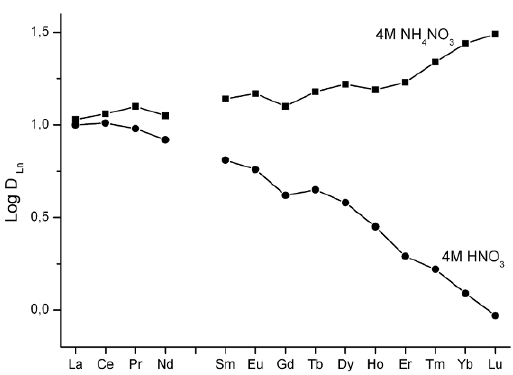
Figure 2. The extraction of lanthanides(III) from 4 M NH and 4 M HNO solutions with 0.01 M solution of compound 3 1 in 1,2-dichloroethane.